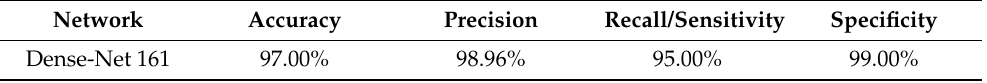
Table 8. The evaluation results of the first experiment on INRIA, ILIDS, and MSMT17 datasets.